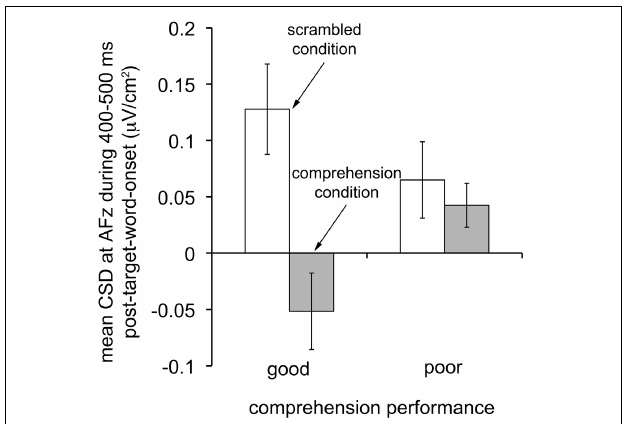
FIGURE 6 | Characteristics of CSD-transformed ERPs that distinguish good from poor reading comprehenders. Mean CSD-transformed ERPs at scalp site AFz during the time period 400–500ms after target word onset in the scrambled (white bars) and comprehension (gray bars) conditions for individuals with good ( N = 15; left bars) and poor ( N = 13; right bars) reading comprehension. Note that good comprehenders turned the frontal-midline current source into a current sink in the comprehension condition, whereas poor comprehenders did not. Error bars represent ± 1 SEM (standard error of the